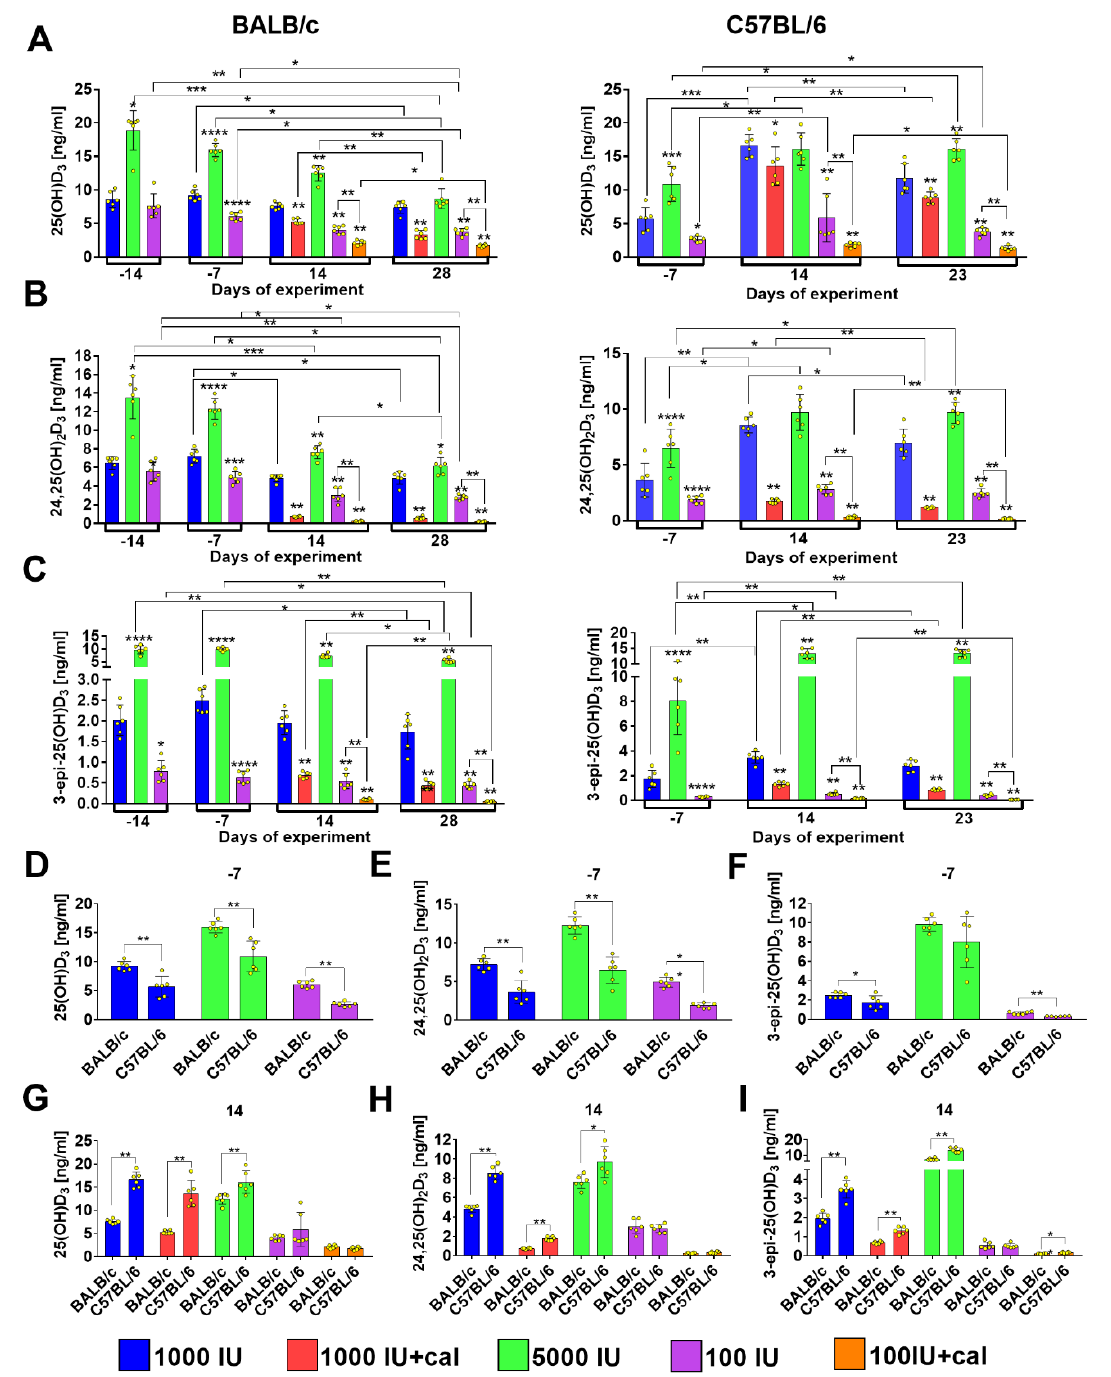
Figure 4. Kinetics of vitamin D metabolite plasma level in healthy BALB / c and C57BL / 6 mice. ( A ) 25(OH)D 3 , ( B ) 24,25(OH) 2 D 3 , and ( C ) 3-epi-25(OH)D 3 plasma level in BALB / c (left column) and C57BL / 6 (right column) mice. ( D – I ) Comparison of plasma levels of vitamin D metabolites between BALB / c and C57BL / 6 mice: on day -7 (5 weeks of experimental diet feeding)—( D ) 25(OH)D 3 , ( E ) 24,25(OH) 2 D 3 , and ( F ) 3-epi-25(OH)D 3 ; on day 14 (8 weeks of experimental diet feeding)—( G ) 25(OH)D 3 , ( H ) 24,25(OH) 2 D 3 , and ( I ) 3-epi-25(OH)D 3 . Data are presented as mean with standard deviation; individual data are also presented as yellow points. Plasma from 6 mice / group was analyzed. Statistical analysis: Dunn’s test for multiple comparisons or Mann–Whitney test. * p < 0.05; ** p < 0.01; *** p < 0.001; **** p < 0.0001.